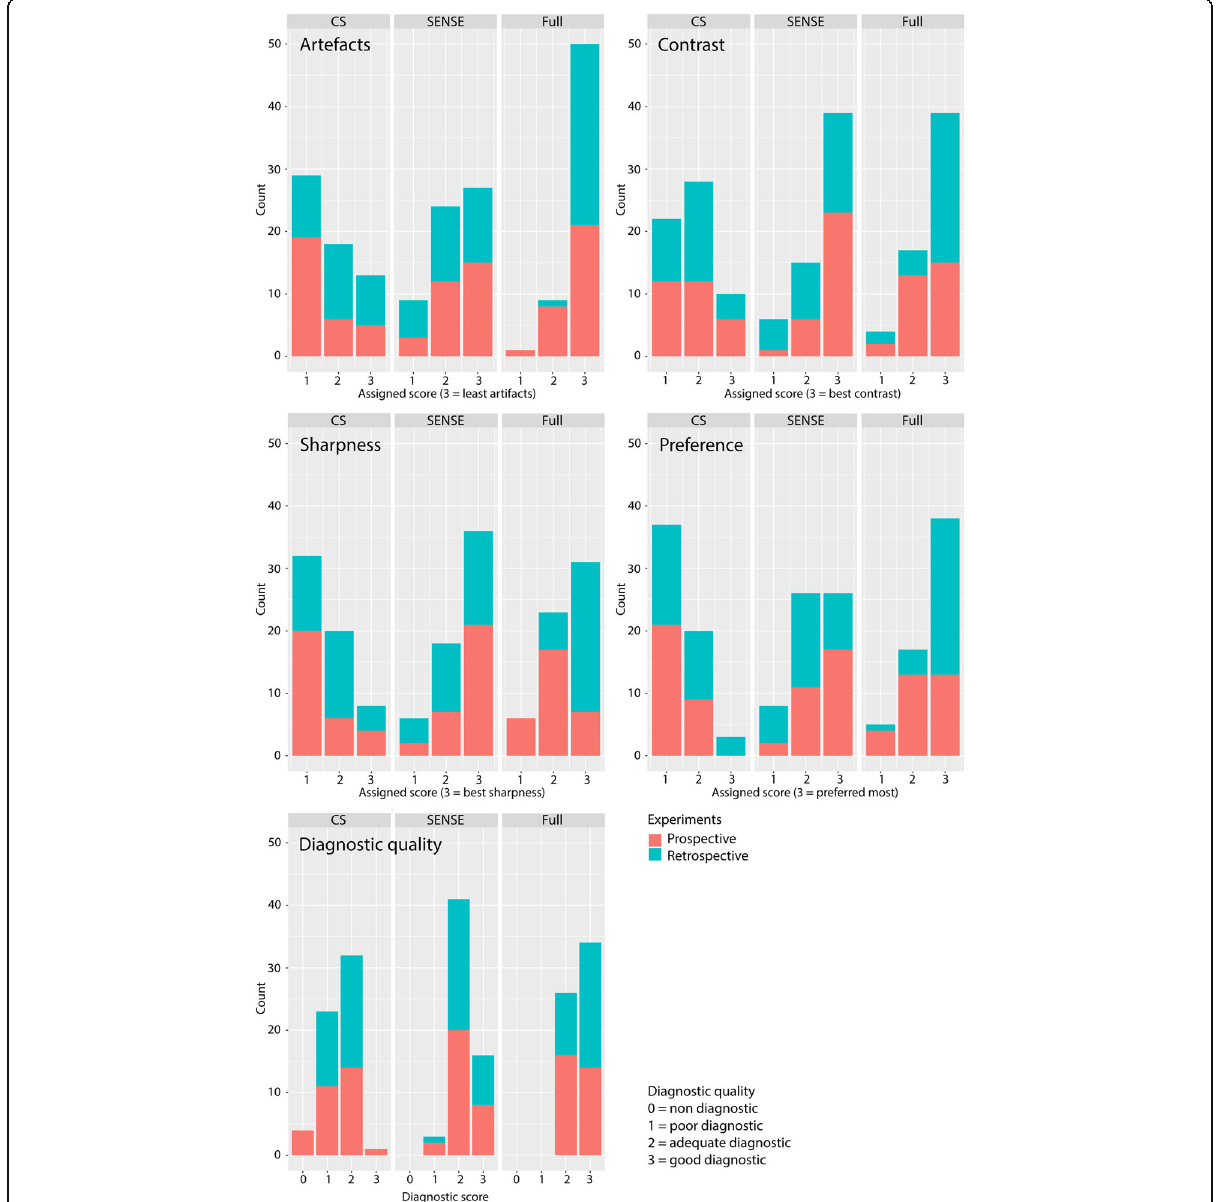
Fig. 5 Histograms of static experiment representing the distribution of the prospective and retrospective datasets per scored value among the various scoring variables. CS compressed sensing, SENSE sensitivity encoding, Full fully sampled three-dimensional balanced fast